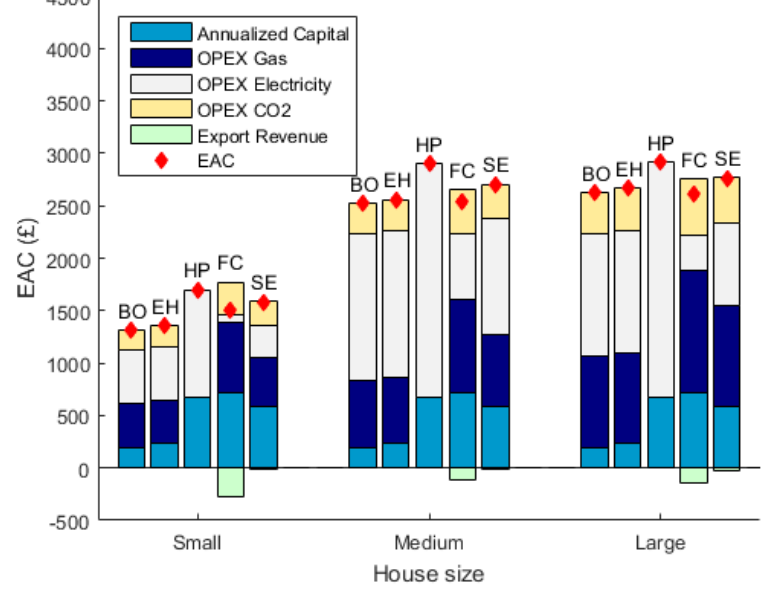
Figure 6. Equivalent Annual Costs in the long run electricity price regime (BO—Boiler, EH—Electric Table 5. Electricity cost composition for the heat pump in the short run electricity price regime.